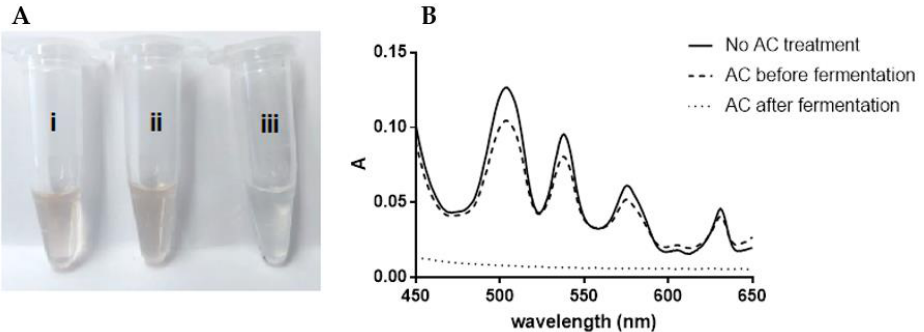
Figure 7. ( A ): Images ( A ) and absorbance spectra ( B ) of solutions of MELs obtained in fermentations